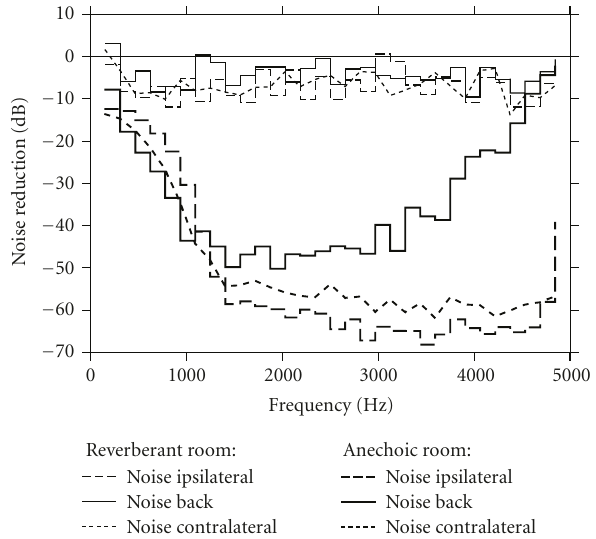
Figure 5: Noise reduction of the adaptive two-microphone system (length of the adaptive filter 10 milliseconds) in 32 frequency bins in simulated reverberant and anechoic